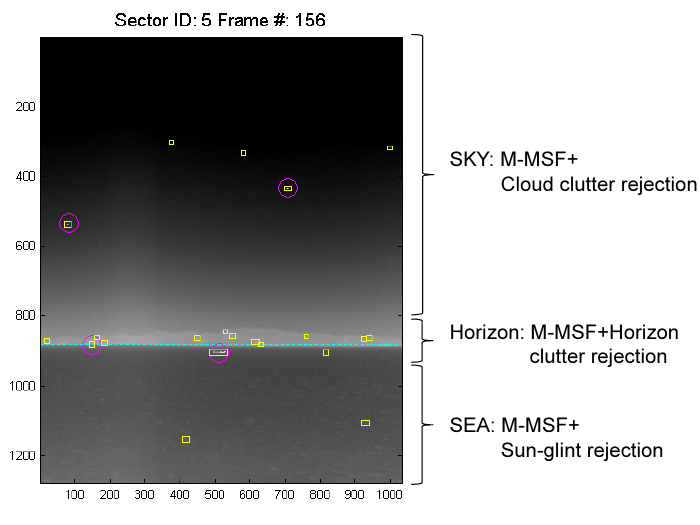
Figure 21. Proposed region-adaptive, small target detection and clutter rejection scheme.